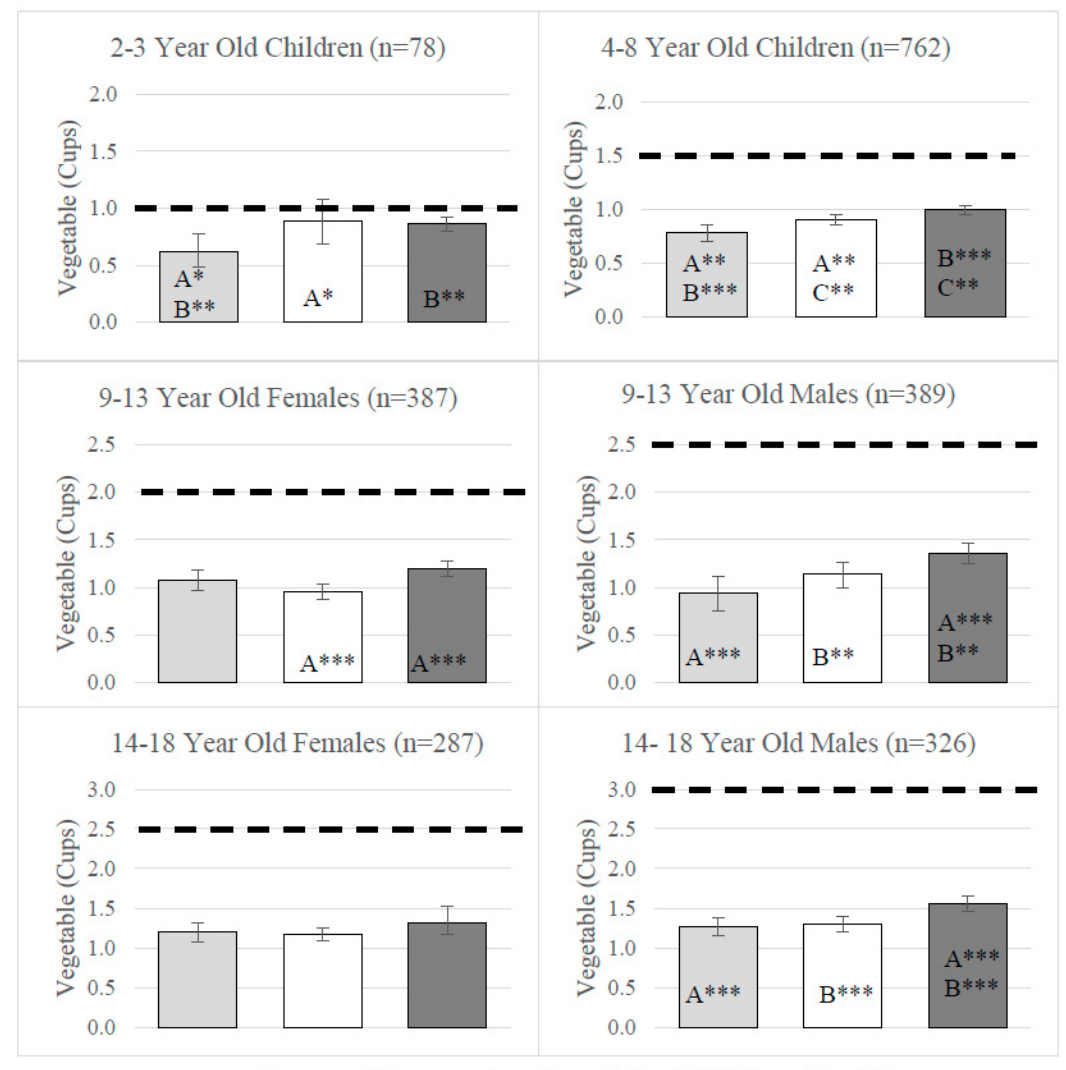
Figure 1. Children’s vegetable consumption across parental perception categories. Notes. Results from multivariate regression analysis showing adjusted average cups of vegetable consumed by parental perception of children’s diet categories. Models included parental perception, sex, age, parental education, federal poverty level, race/ethnicity, SNAP participation, and WIC participation. Bars with the same letter (A, B, or C) represent significant differences in consumption across those perception categories (* p ≤ 0.05; ** p ≤ 0.01; *** p ≤ 0.001). MyPlate recommendations for each age and sex category are represented by black dashed lines.